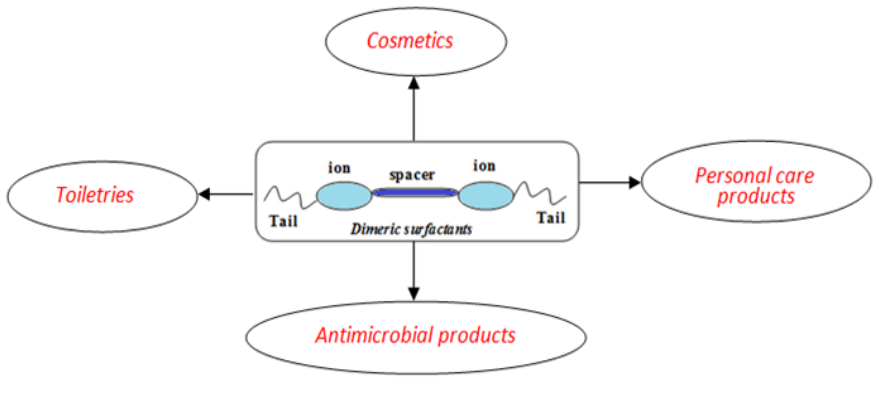
Figure 1. Systematic representation of dimeric